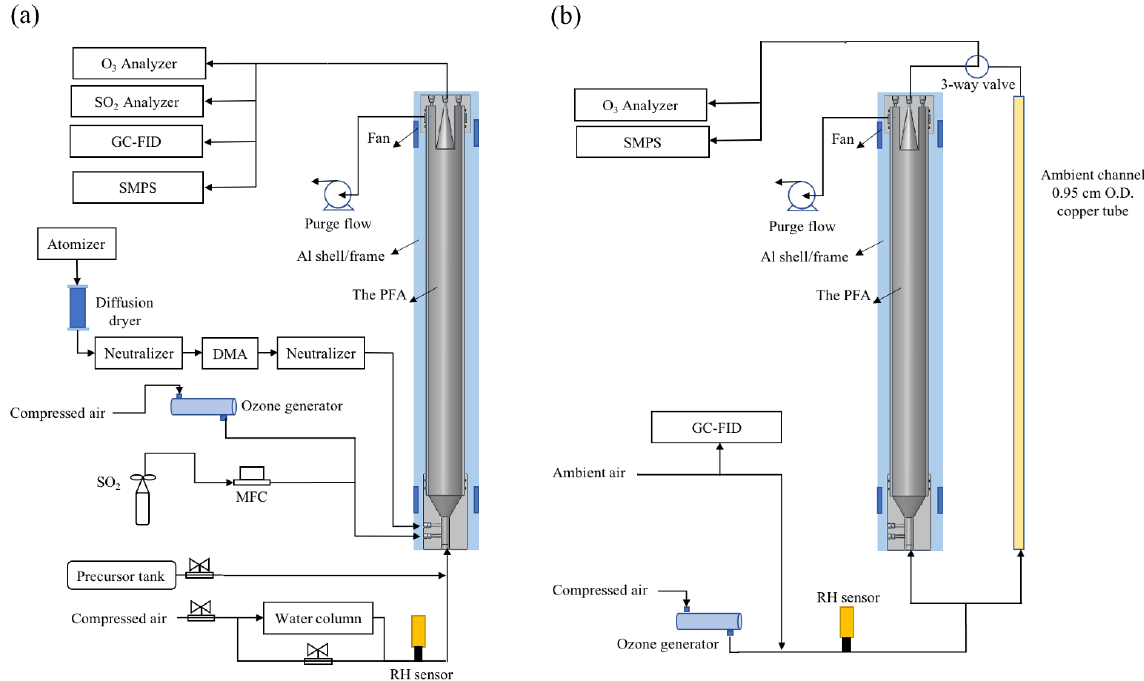
Figure 3. Schematic diagram of the PFA OFR and associated experimental setup for (a) the laboratory and (b) field